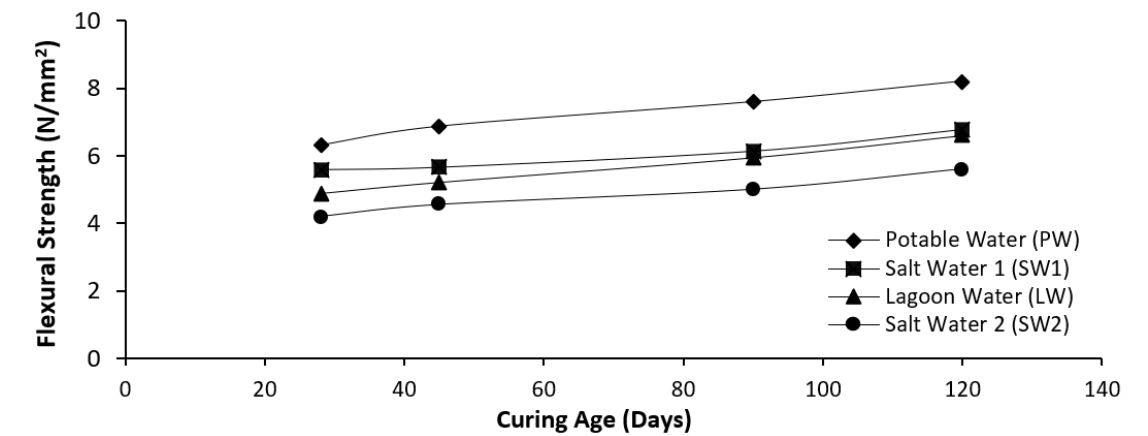
Figure 5. Effect of curing medium on the flexural strength of